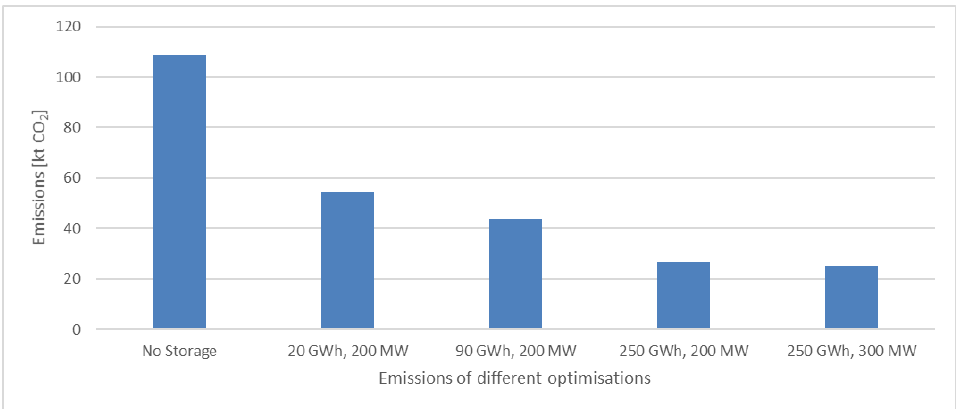
Figure 6. One-year emissions for different optimisations.